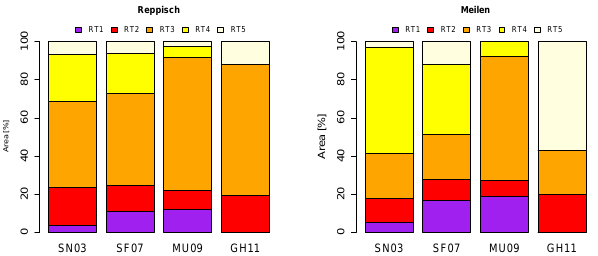
Figure 6. Percentage of total catchment area assigned to each runoff type in the Reppisch and Meilen catchments with the four different mapping approaches.